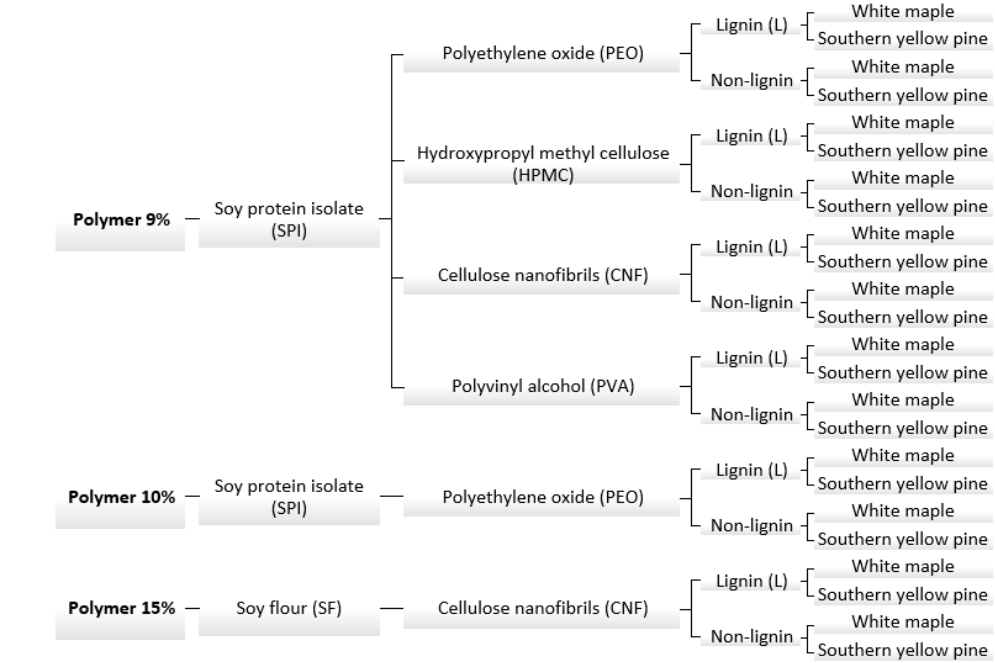
Figure 1. Experimental design diagram.